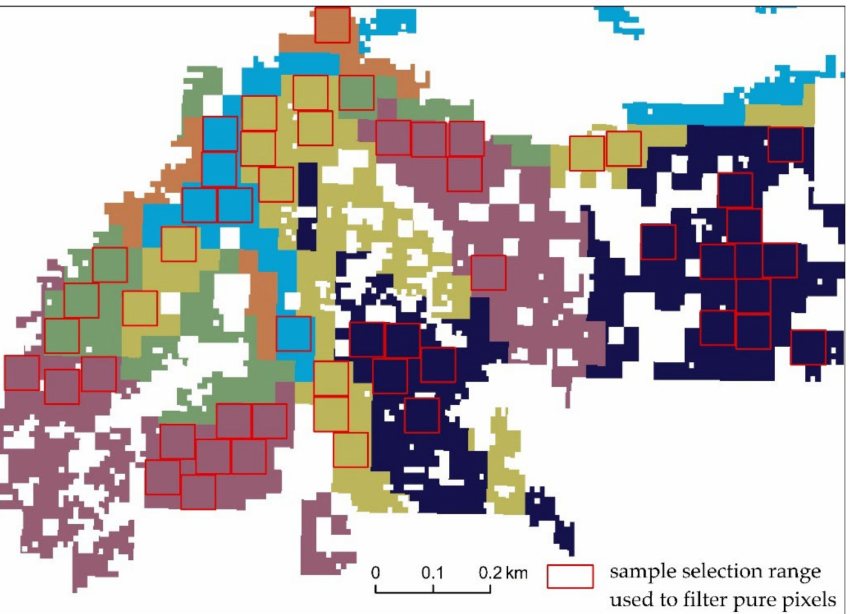
Figure 5. The example of the final sample selection range used to filter pure pixels and to obtain random